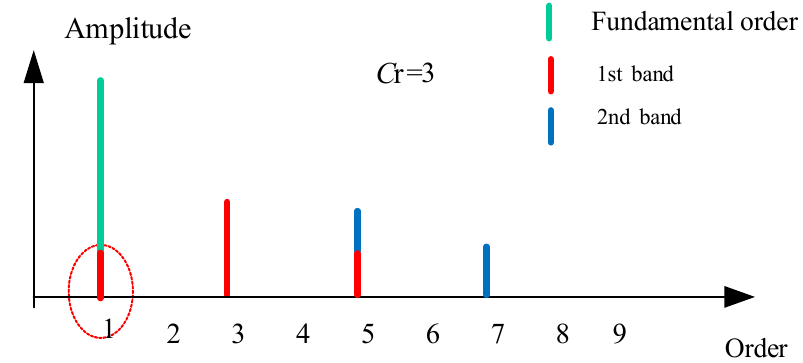
Figure 3. Frequency spectrum for two-level SPWM output when C r = 3.